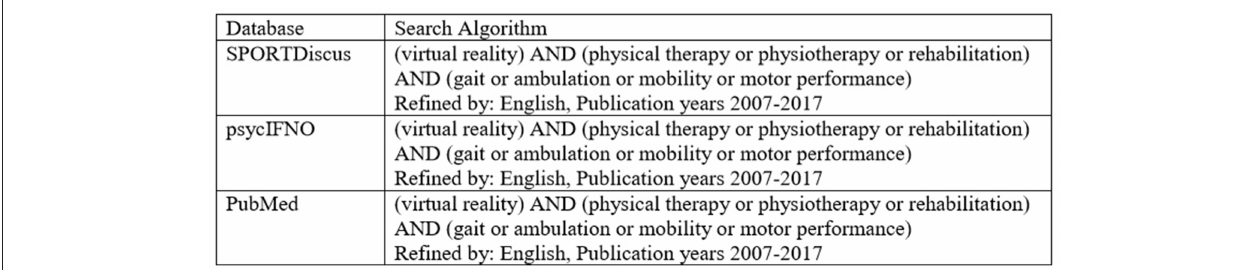
FIGURE 1 | Database Search algorithm.